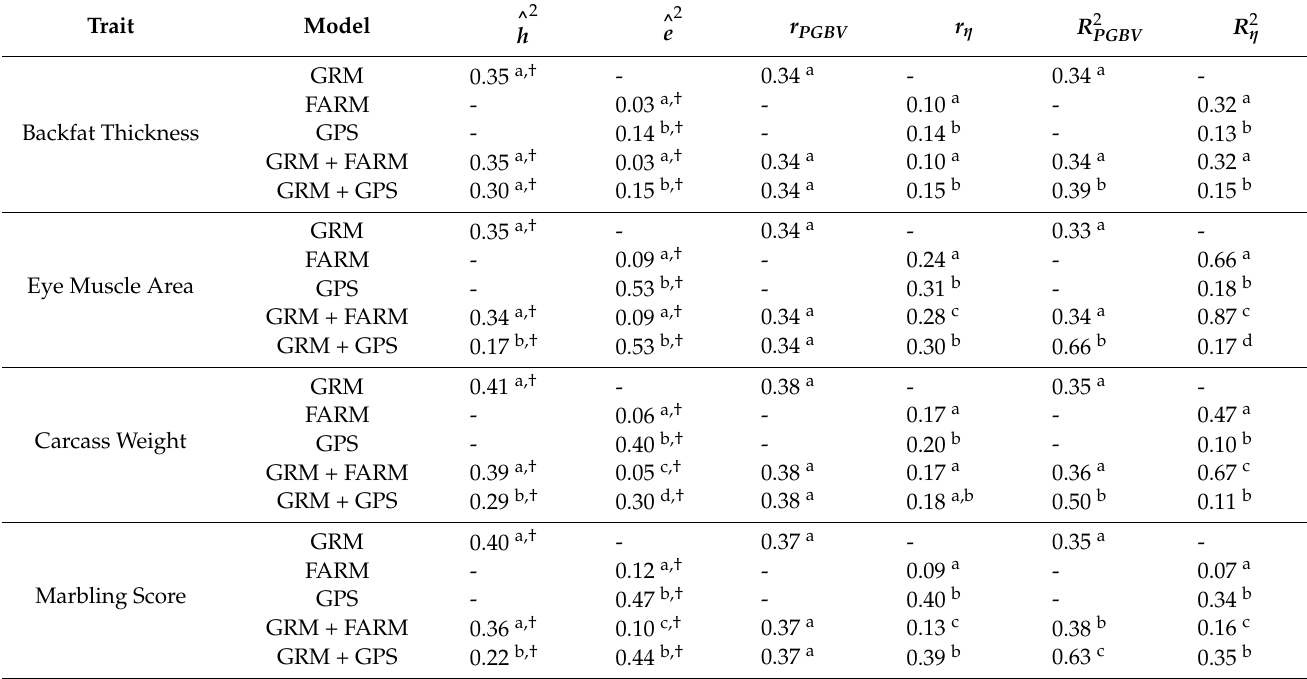
Table 4. Heritability and environmentability estimates (ˆ h 2 = σ 2 g / σ 2 y and ˆ e 2 = σ 2 η / σ 2 y ), prediction accuracy of genomic breeding values and herd effects ( r PGBV = cor ( (cid:101) g test , y test ) and r η = cor ( (cid:101) η test , y test ) ), reliability of predicted genomic breeding /ˆ h 2 and R 2 2 ), for all four traits and all the five models evaluated. Values in = r 2 = r 2 values and herd effects ( R 2 η η /ˆ e PGBV PGBV this table represent the mean over 100 cross-validation replicates of each model.